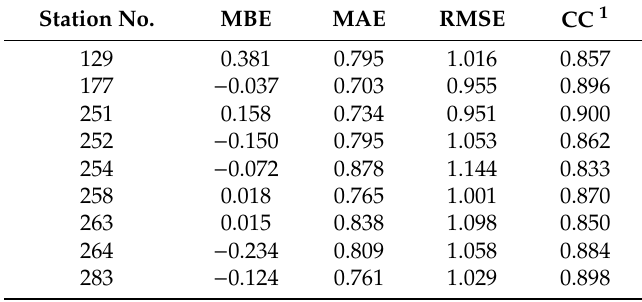
Table 4. Accuracy statistics of the nine stations in the croplands in South Korea, 2013–2019. Station No.